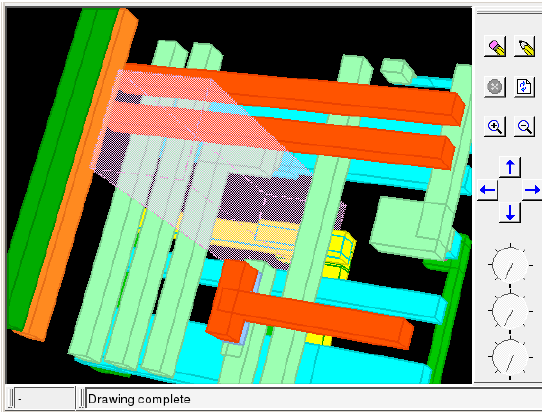
Figure 25. FIB candidate on diagnostics net.